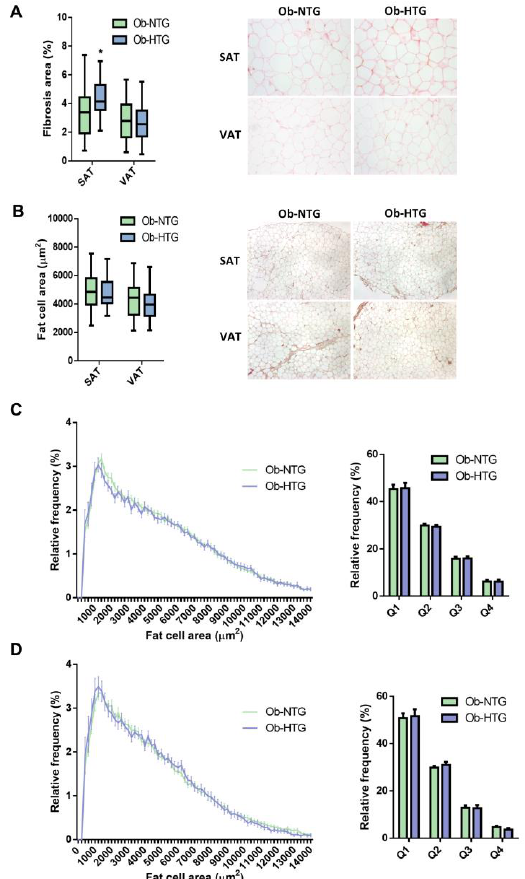
Figure 1. Analysis of WAT fibrosis and fat cell size distribution in Ob-NTG and Ob-HTG subjects. ( A ) Comparison of histological pericellular fibrosis and representative images. Data are presented as the mean ratio of fibrous tissue area stained with picrosirius red/total tissue surface. ( B ) Comparison of mean adipocyte area and representative images. ( C , D ) Frequency distribution analysis of fat cell areas divided by size into bin intervals of 200 µm2 and size quartiles in SAT ( C ) and VAT ( D ). Data are presented as means ± SD. Ob-NTG, subjects with severe obesity and normotriglyceridemia; Ob-HTG, subjects with severe obesity and hypertriglyceridemia; SAT, subcutaneous adipose tissue; VAT, visceral adipose tissue. * = p < 0.05.